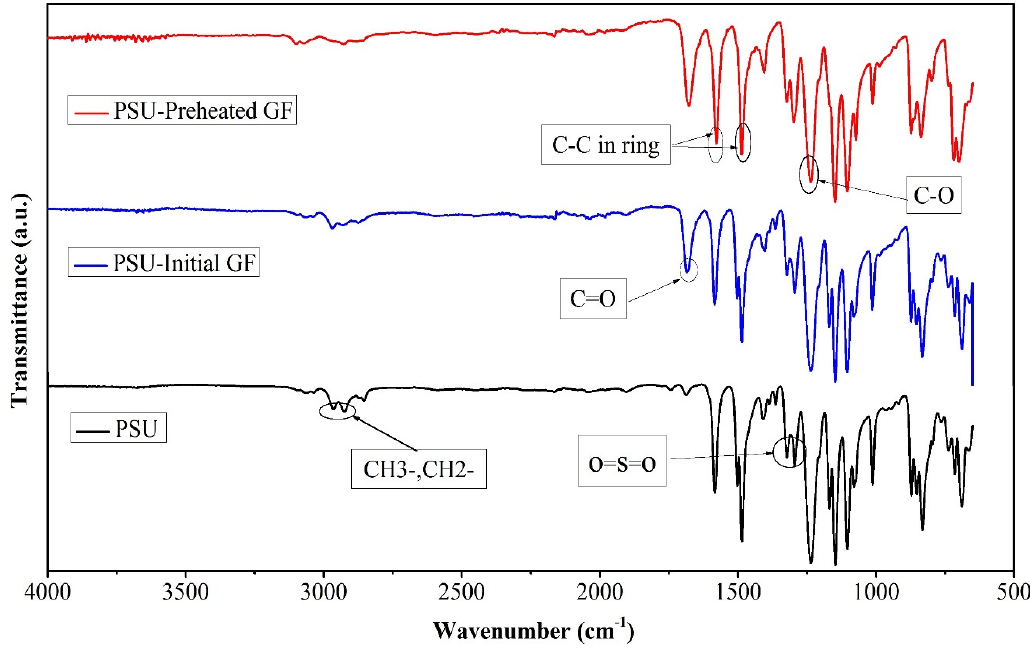
Figure 2. FTIR spectra for the initial PSU and 50/50 PSU composites reinforced with initial and preheated GF.